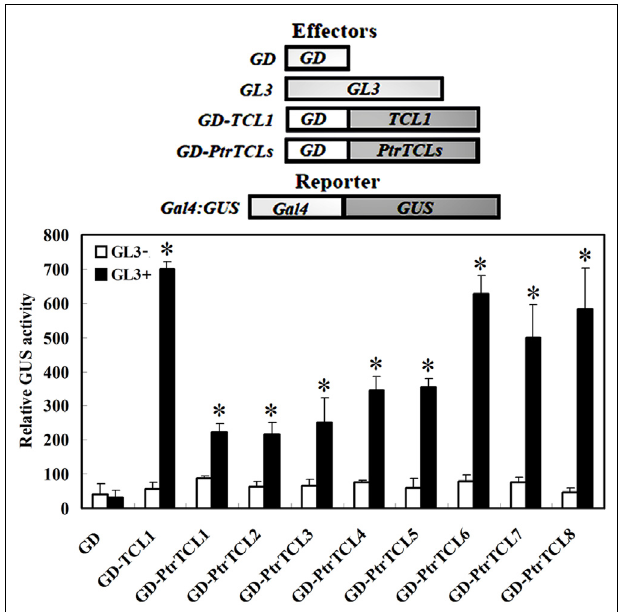
FIGURE 2 | Poplar R3 MYBs interact with GL3 in plant cells. Reporter gene and effector gene plasmids were co-transfected into protoplasts isolated from Arabidopsis rosette leaves. Protoplasts were incubated in darkness for 20–22 h after transfection, and then GUS activity was measured. Data represent the mean ± SD of three replicates. Reporter and effector constructs are diagrammed at the top of the figure. *significantly different from the absence of GL3 (GL3-; P < 0.001).